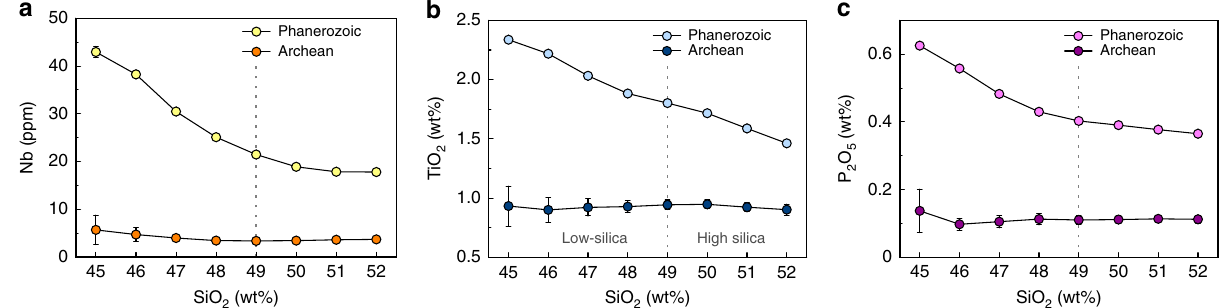
Fig. 3 Combined Nb, TiO 2 , and P 2 O 5 -SiO 2 compositional trends of ma fi c rocks. a – c Diagrams of the combined Nb-SiO 2 , TiO 2 -SiO 2 , and P 2 O 5 -SiO 2 compositional trends of ma fi c rocks formed in the Archean and in the Phanerozoic, respectively. The round circles are mean values corresponding to SiO 2 concentrations ranging from 45 to 52 wt% (1 wt% SiO 2 interval) as estimated by the Bootstrap methods. Error bars denote two standard errors of the mean (s.e.m.). The gray vertical-dashed lines divide the rocks into low-silica (45 – 49 wt% SiO 2 ) and high-silica (49 – 52 wt% SiO 2 ) ma fi c rock